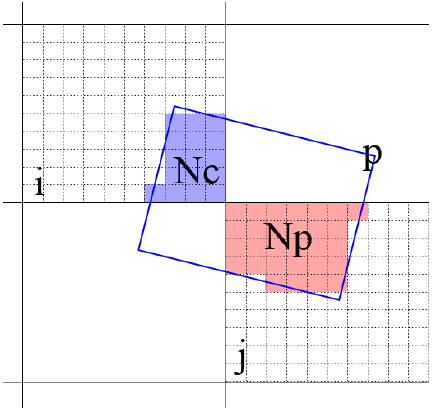
Figure B1. Illustration of how the original PHLET model grid cell i is projected to the satellite pixel p and then to the final grid cell j through the SCM approach. The size of the satellite pixel is scaled down to be comparable with the size of a model grid cell for illus- tration